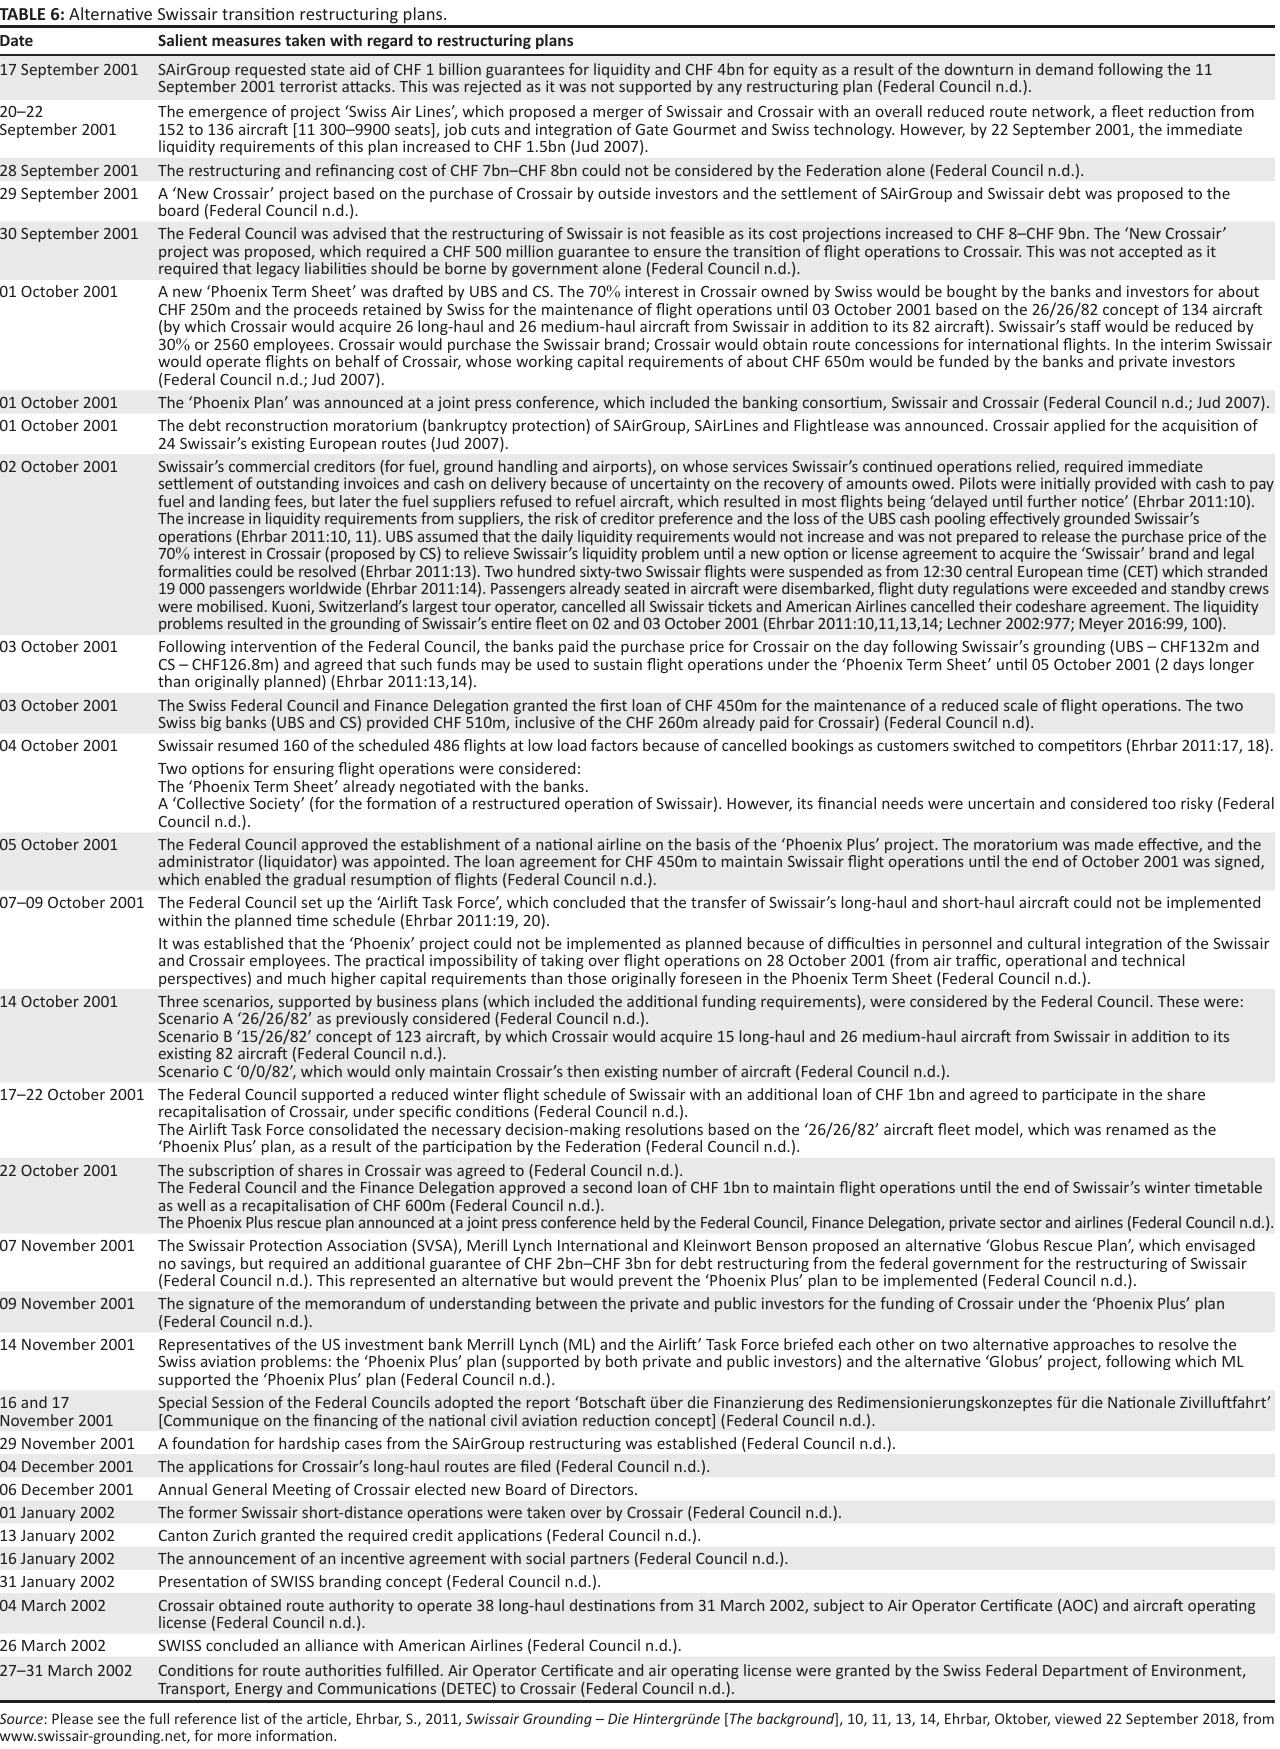
TABLE 6: Alternative Swissair transition restructuring